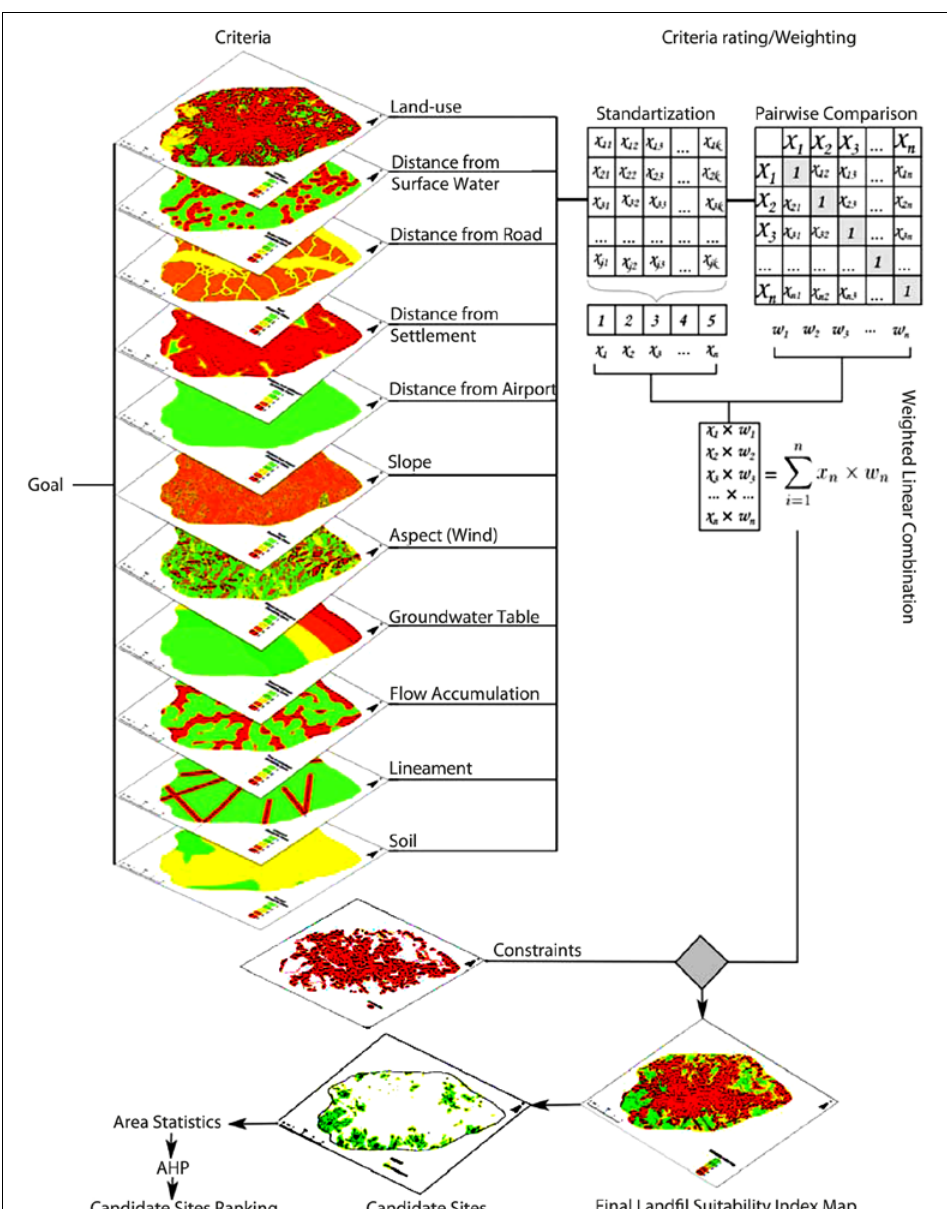
Fig. 3. Methodology of the